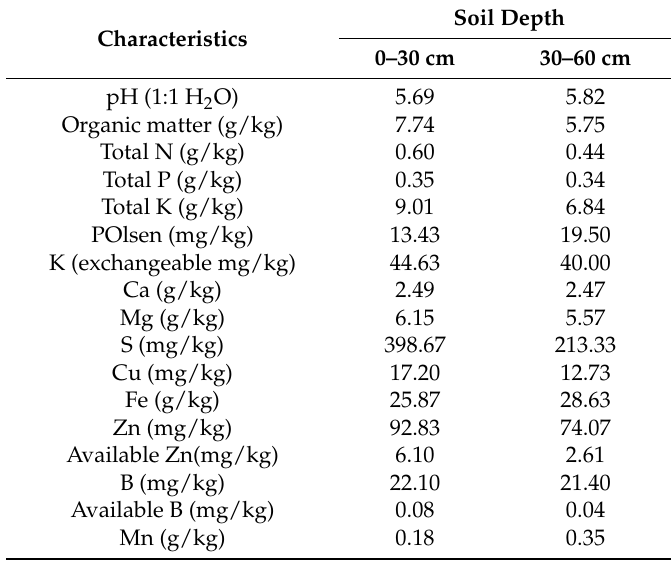
Table 1. Some chemical characteristics of the experimental soil of the L. cubeba (Lour.) Persoon forest. Characteristics